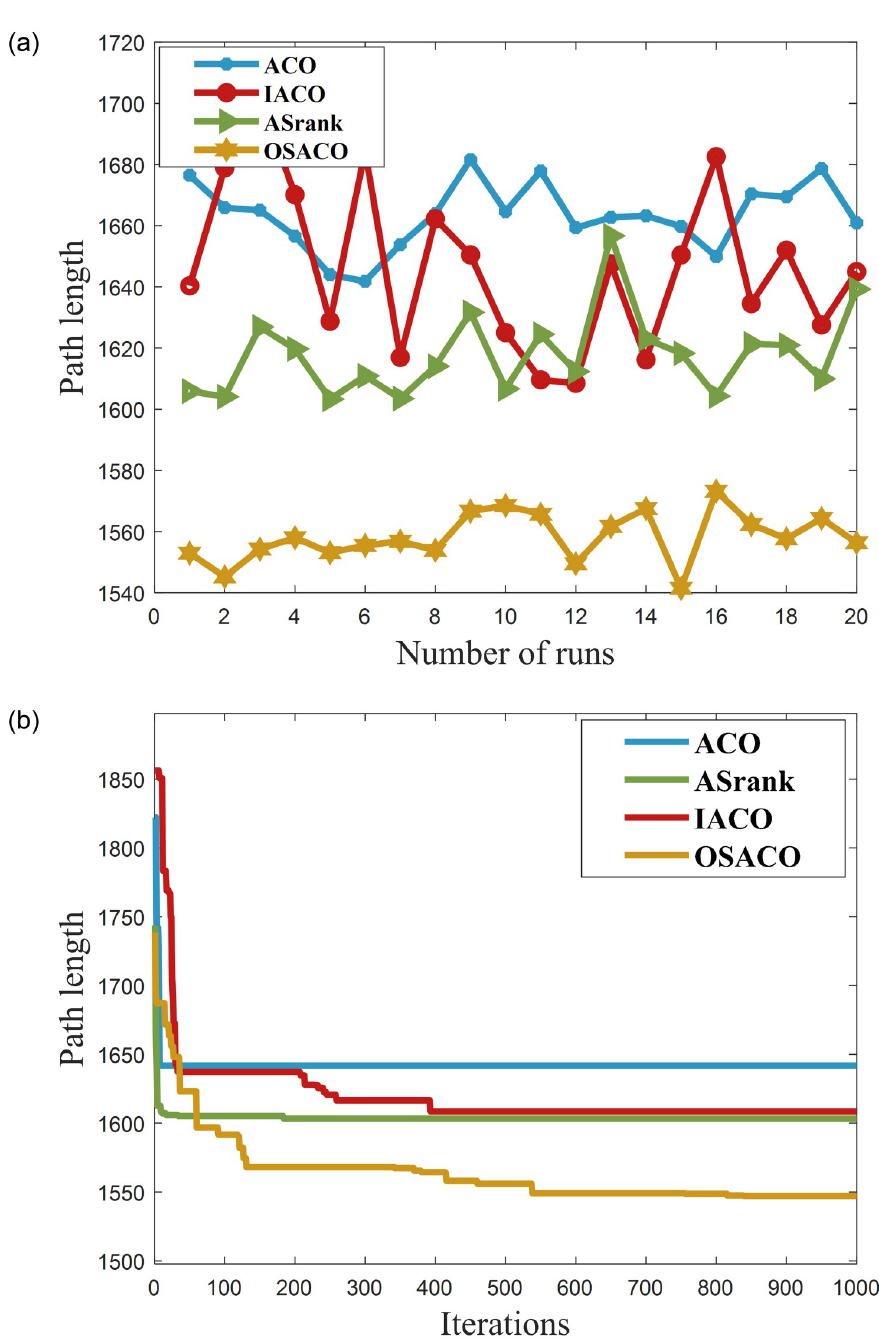
Fig 3. Number of independent runs and convergence curves of the four algorithms at 90 fruit numbers. (a) Four algorithms run independently for 20 times result graph. (b) Convergence curves under the optimal path conditions.